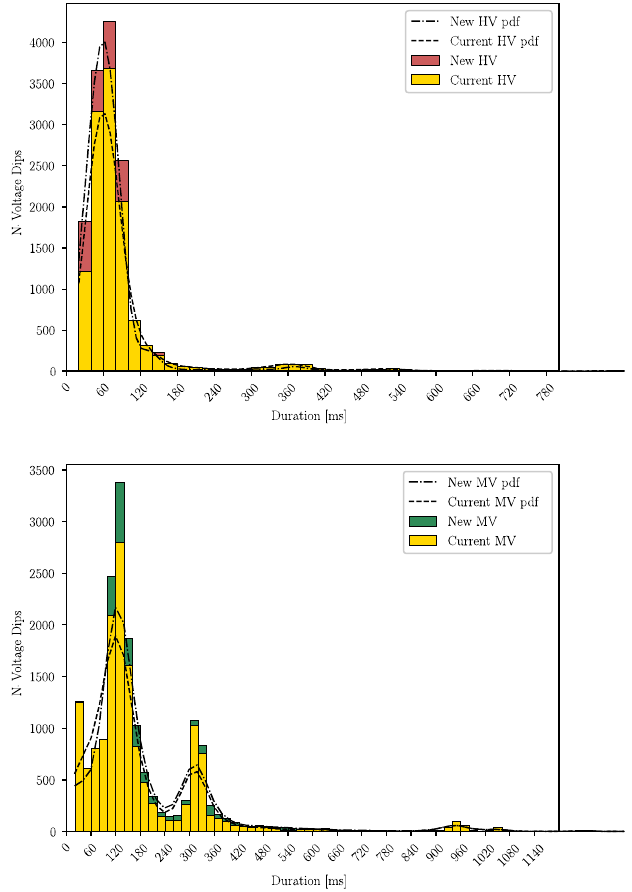
Figure 10. Voltage dips duration frequency histograms: current and new criteria for HV origin events ( top ) and MV ones ( bottom ).